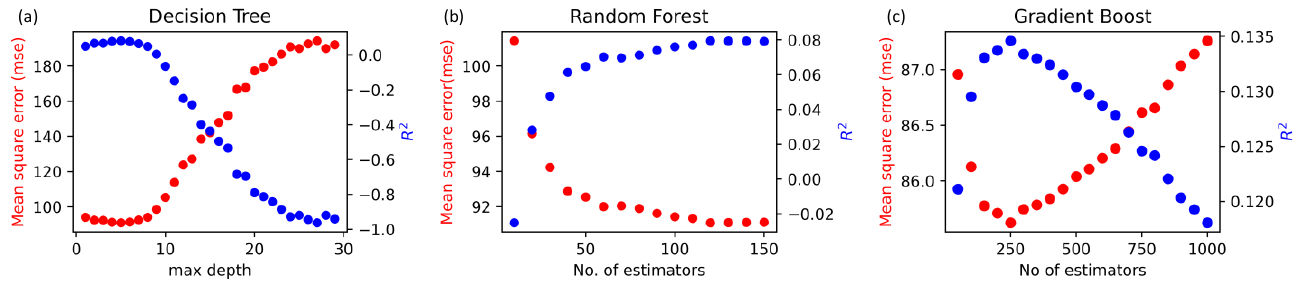
Figure 4. Optimization of the decision tree regressor ( a ), random forest regressor ( b ), gradient boosting regressor ( c ) algorithms. Unit for mean square error is (mm/day) 2. Table 3. Additional parameters for the decision tree, random forest, and gradient boosting regres- sors used in this study.